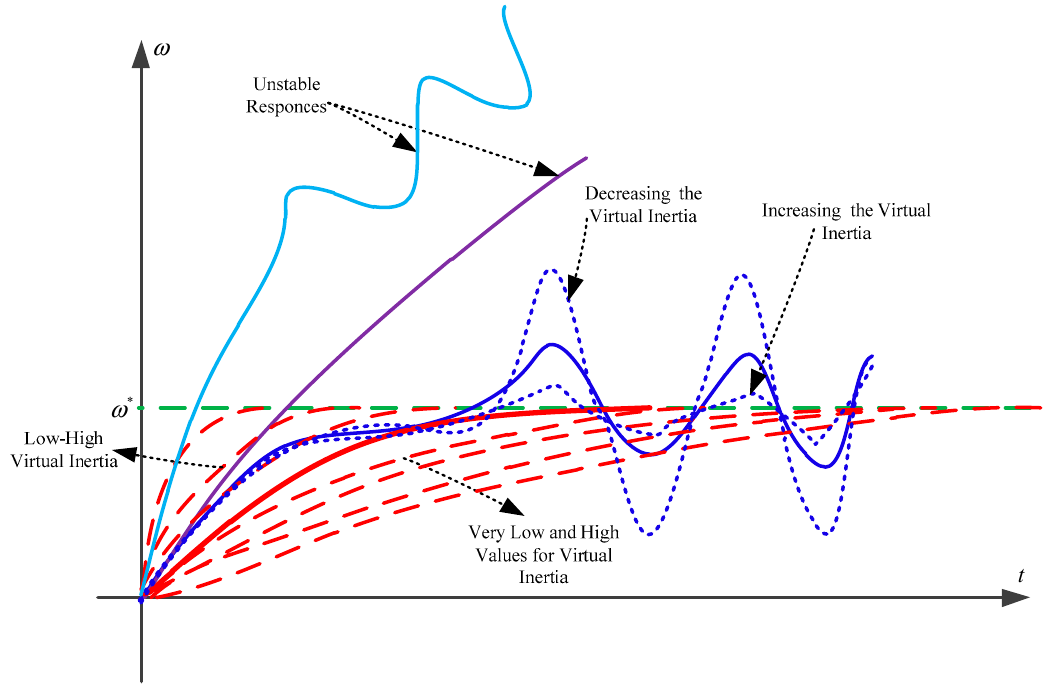
Figure 4. The virtual inertia effects on the grid angular frequency.